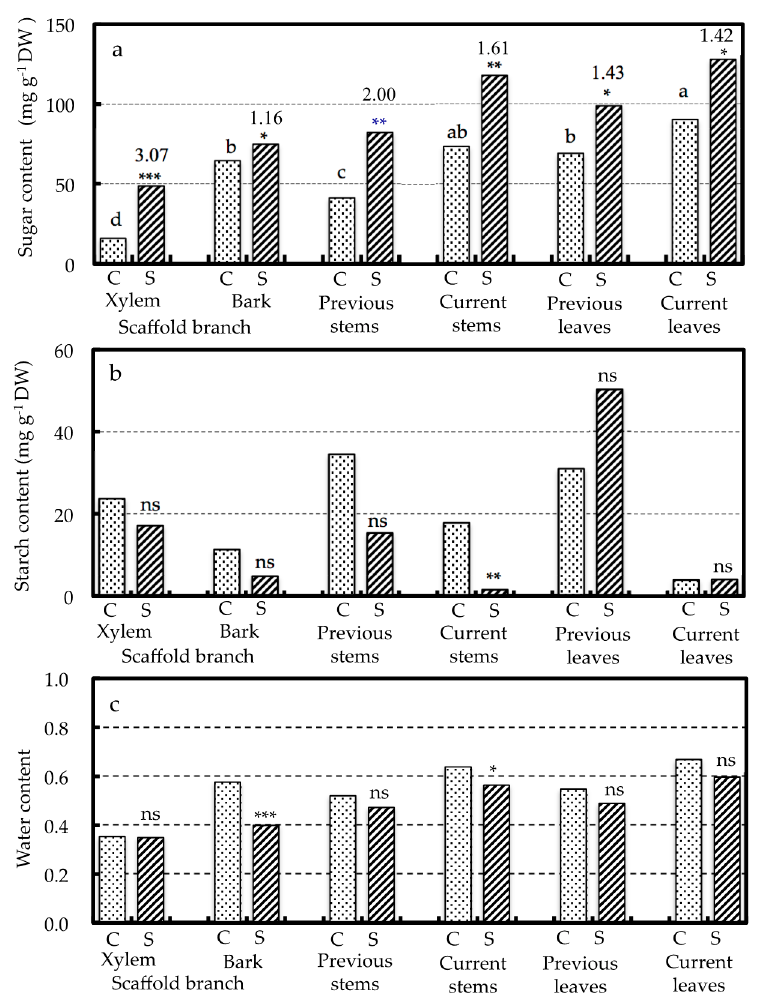
Figure 2. Soluble sugar ( a ), starch ( b ) and water ( c ) contents of various plant parts in Meiwa kumquat trees as affected by SWD treatment. C and S indicate CONT and SWD, respectively. The numbers above the bar of sugar content are the ratio of SWD to CONT. *, **, *** and ns indicate significant difference between the treatments at p = 0.05, 0.01 and 0.001 and non-significant by t -test, respectively ( n = 3). Different letters above CONT bar indicate significant differences among the plant parts at p = 0.05 by Tukey HSD test ( n = 3). Water content is expressed as the ratio of water to fresh weight.